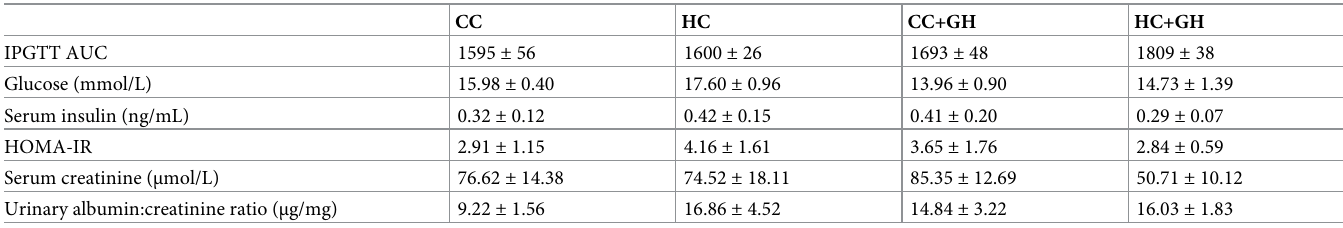
Table 4. Metabolic parameters of week 9 offspring.